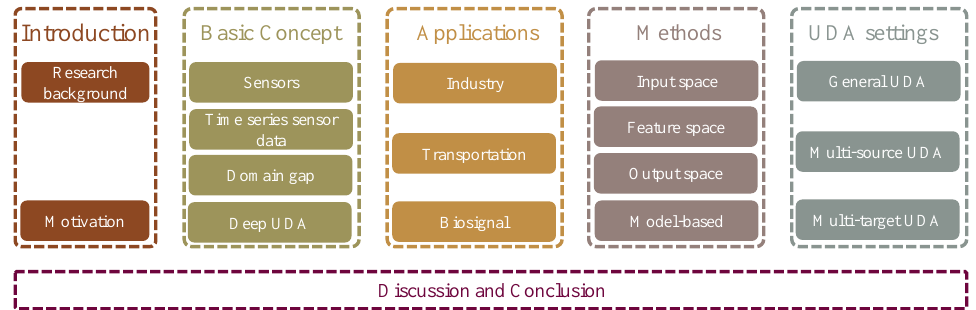
Figure 1. The organization of this